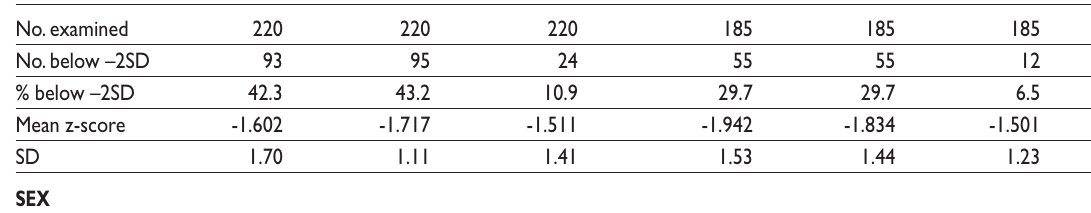
Table 4. Summary of Nutritional Indices (Z-scores) of Rural and Urban Children RURAL URBAN Height-for-age Height-for-age Weight-for-age